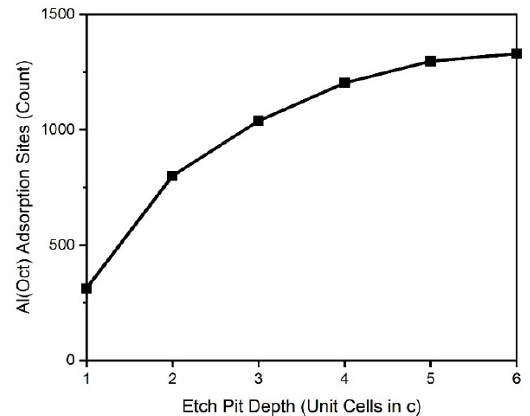
Figure 6. The number of available monodentate octahedral adsorption sites on the (001) muscovite surface is shown depending on etch pit depth. All surfaces have one initial pit placed with the respective depth. Two million atoms are then dissolved from the surface. With increasing etch pit depth, an increase of octahedral surface atoms is observed. For larger etch pit depths, the number appears to become constant.